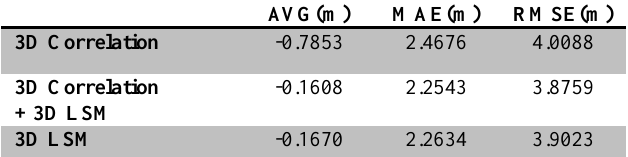
Table 5. DEM accuracy test results by number of pyramid images